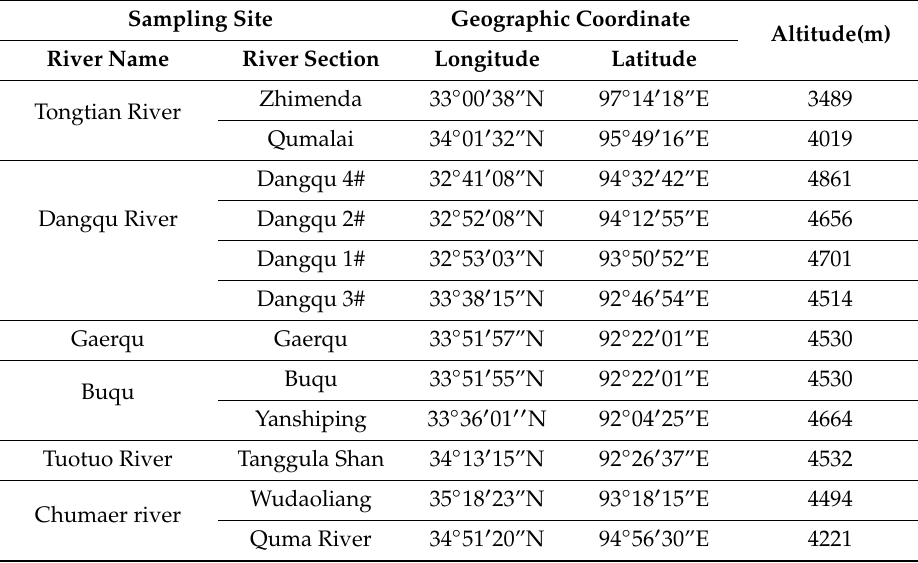
Table 1. The geographic coordinate and altitude of sampling